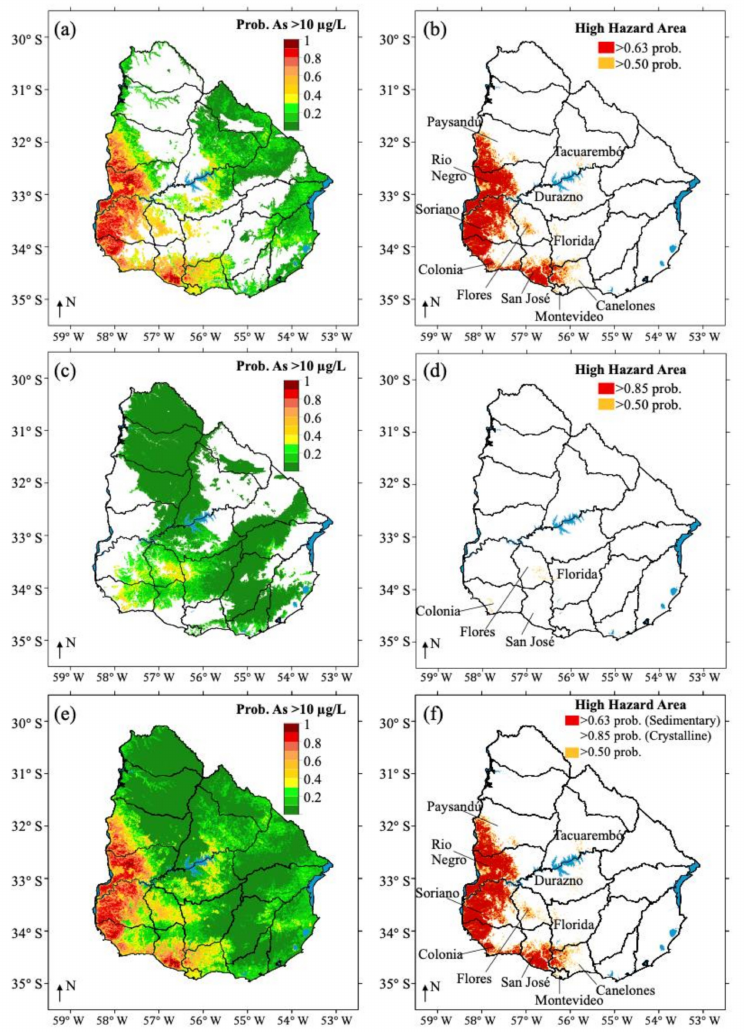
Figure 4. Hybrid machine learning models of Uruguay groundwater arsenic concentrations in sed- imentary (3A-HML-Sed) and crystalline (3B-HML-Cry) aquifers. Sedimentary aquifers: ( a ) map of probability of groundwater arsenic concentrations exceeding 10 µ g/L; ( b ) map of high groundwater arsenic hazard areas (defined here by a probability exceeding cutoff values of 0.50 or 0.63); crystalline aquifers: ( c ) map of probability of groundwater arsenic concentrations exceeding 10 µ g/L; ( d ) map of high groundwater arsenic hazard areas (defined here by a probability exceeding cutoff values of 0.50 or 0.85); hybrid machine learning and expert system model for all aquifers (3C-HML-Geol): ( e ) map of probability of groundwater arsenic concentrations exceeding 10 µ g/L; ( f ) map of high groundwater arsenic hazard areas; ( e ) was obtained by combining ( a , c ); ( f ) was obtained by combining ( b , d